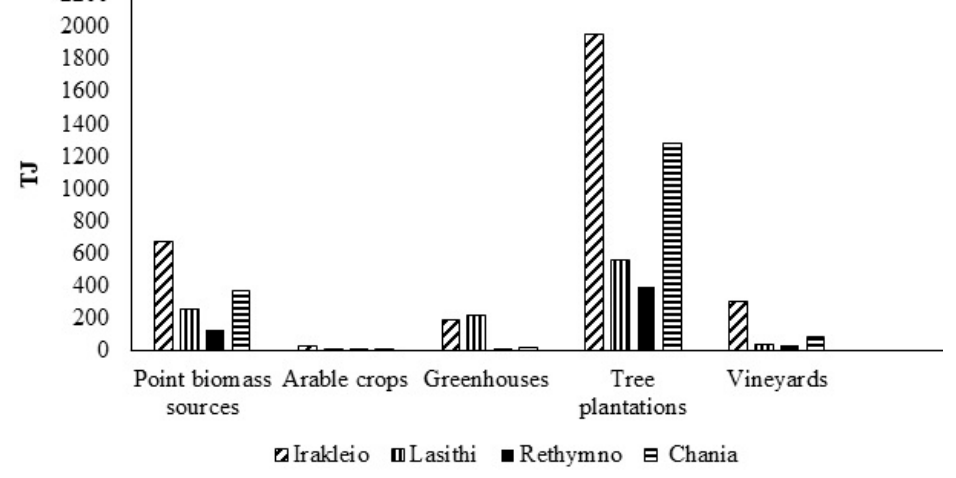
Figure 8. Available biomass energy by source and regional unit of Crete (in TJ) [16,21,22].